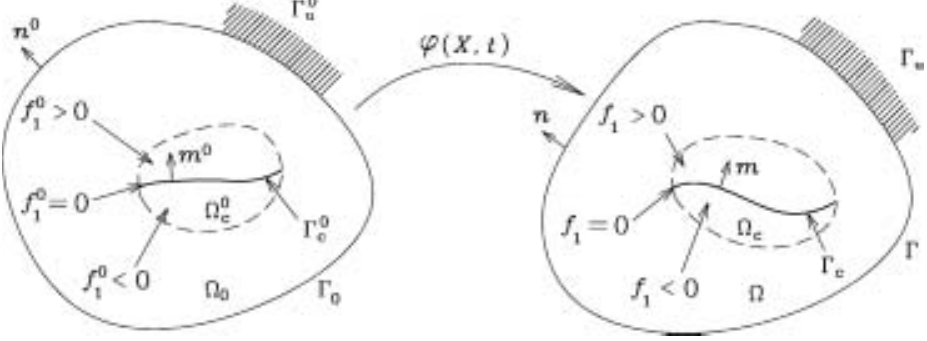
Fig. 1. A two dimensional body with a crack and its representation in the initial and the current domain.